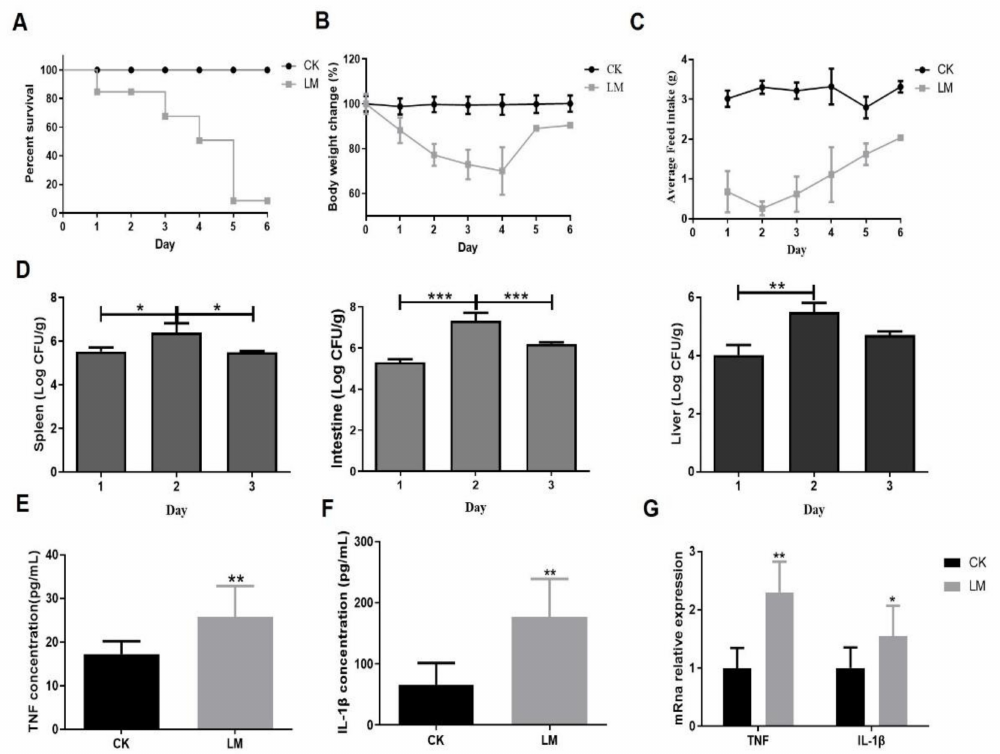
Figure 1. The pathological changes in mice after L. monocytogenes infection. ( A ) Time course of survival rate of mice. ( B ) Time course of body weight change in mice. ( C ) Time course of average feed intake of mice. ( D ) L. monocytogenes burden in the spleen, intestine and liver. ( E , F ) The concentration of TNF and IL-1 β in jejunum homogenate of mice. ( G ) mRNA levels of TNF and IL-1 β from homogenized jejunum samples. * p < 0.05, ** p < 0.01, *** p <